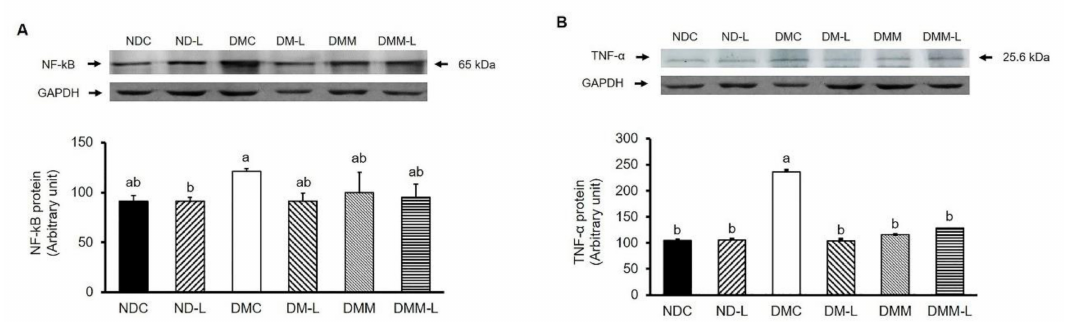
Figure 5. E ff ects of L. paracasei HII01 on Western blotting of inflammatory protein marker ( A ) NF-kB ( B ) TNF- α in skeletal muscle of experimental groups. NDC, normal control rats; ND-L, normal control rats supplemented with L. paracasei HII01 (10 8 CFU / day); DMC, diabetic rats control; DM-L, diabetic rats supplemented with L. paracasei HII01 (10 8 CFU / day); DMM, diabetic rats treated with metformin 30 mg / kg; DMM-L, diabetic rats supplemented with combination of L. paracasei HII01 (10 8 CFU / day) and metformin 30 mg / kg. NF-kB, nuclear factor-kappa B; TNF- α , tumor necrosis factor alpha. All data are expressed as mean ± SEM. Di ff erent lowercase letters indicate significant di ff erences among di ff erent groups ( p < 0.05).